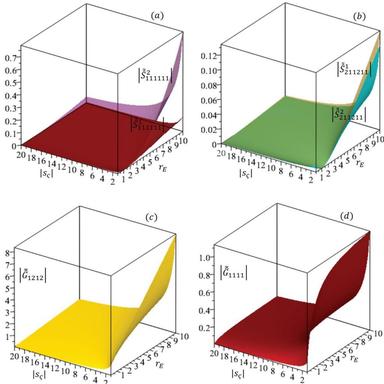
(a) Magnitudes | ˜ Sˆ1 111111| and | ˜ Sˆ2 111111| (red and violet surfaces, respectively) are compared by varying the ratio rE and the magnitude |sς |. (b) Magnitudes | ˜ Sˆ1 211211| and | ˜ Sˆ2 211211| (gold and green surfaces, respectively) are compared with respect rE and |sς |. (c) Magnitude | ˜ Gˆ1212| is depicted by varying the ratio rE and the magnitude |sς |. (d) Magnitude of | ˜ Gˆ1111| is represented by changing the ratio rE and the magnitude |sς |. The functions are obtained for rρ = 10, τ i ς =